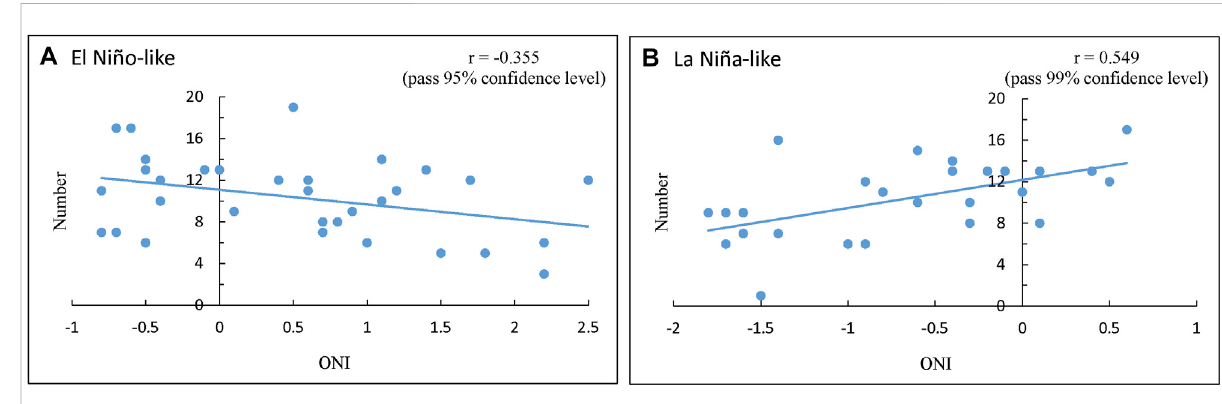
ONI in January and the number of STYs in the entire year. Solid lines represent the linear regression of the scatter. (A) El Niño-like years. (B) La Niña-like years.